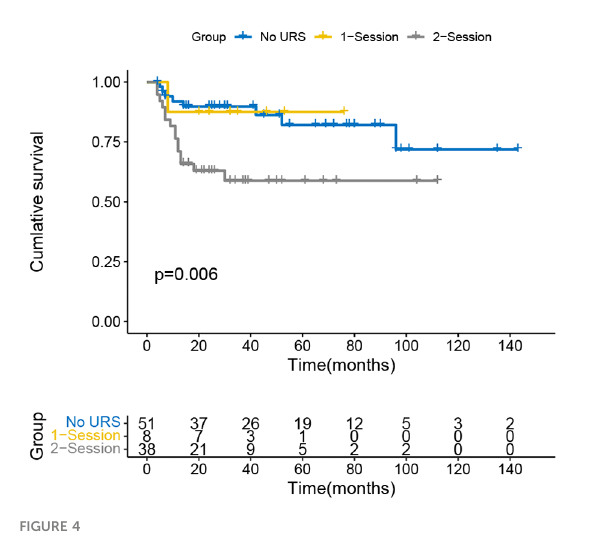
FIGURE 4 Survival analysis of intravesical recurrence in patients with renal pelvic